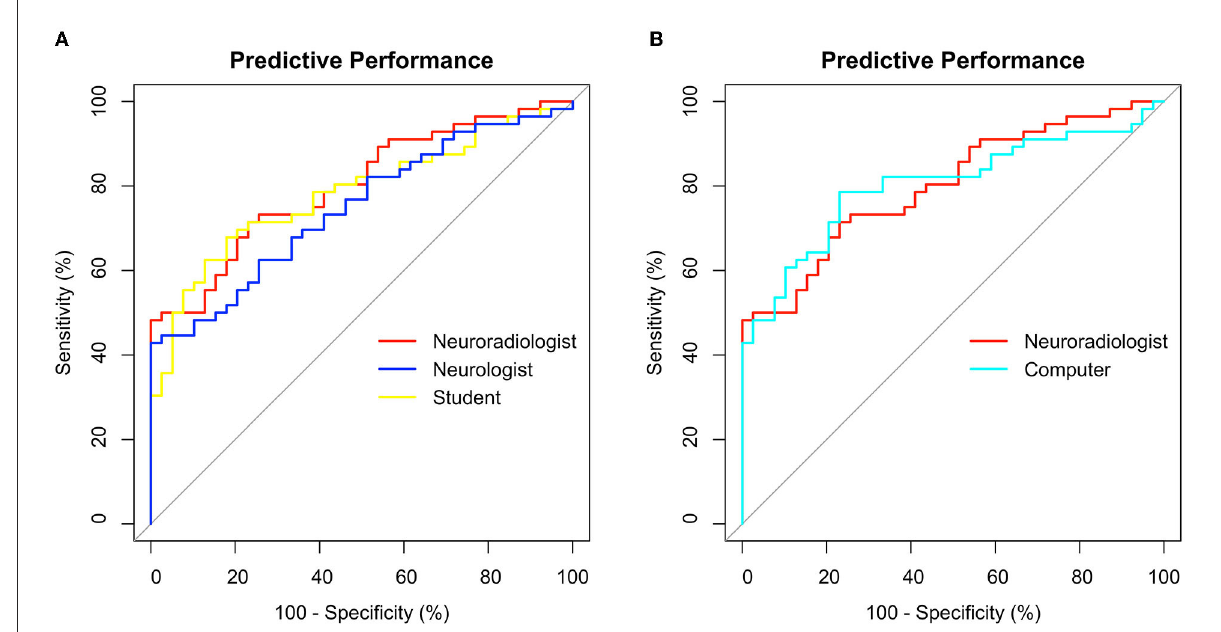
FIGURE5 Receiver operating characteristics (ROC) for poor outcome prediction after CA using GWR rated by (A) 3 different human raters (B) Neuroradiologist vs. Computer. Sensitivity and Specificity in